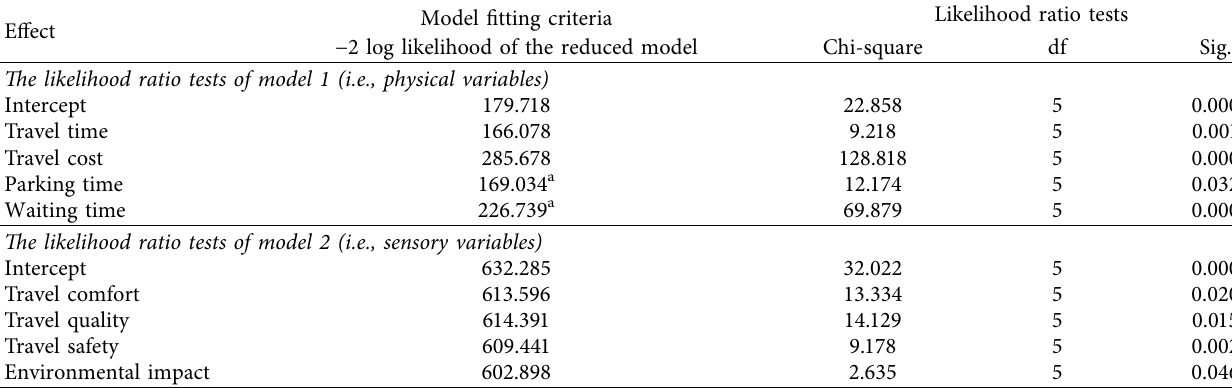
Table 8: The likelihood ratio tests of the selected model.